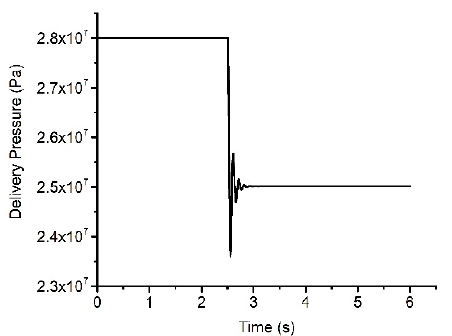
Figure 7. The delivery pressure of EHPAAPP with linear quadratic regulator (LQR) method in the case of input signal change from 28 MPa to 25 MPa.